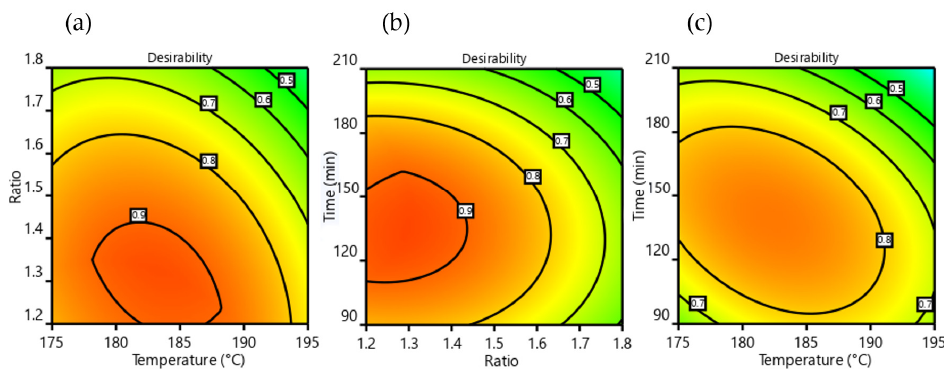
Figure 5. Desirability contour maps, ( a ) vs urea/Gly MR - temperature, ( b ) vs time – urea/Gly MR and ( c ) vs time - temperature.